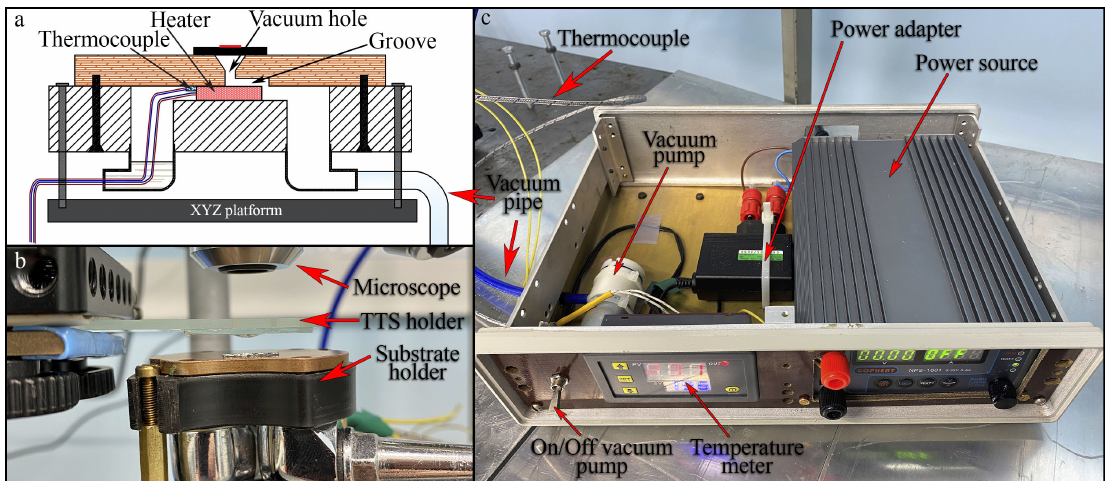
Figure 4. ( a ) Schematics of the substrate holder ( b ) photo of the substrate holder, ( c ) photo of